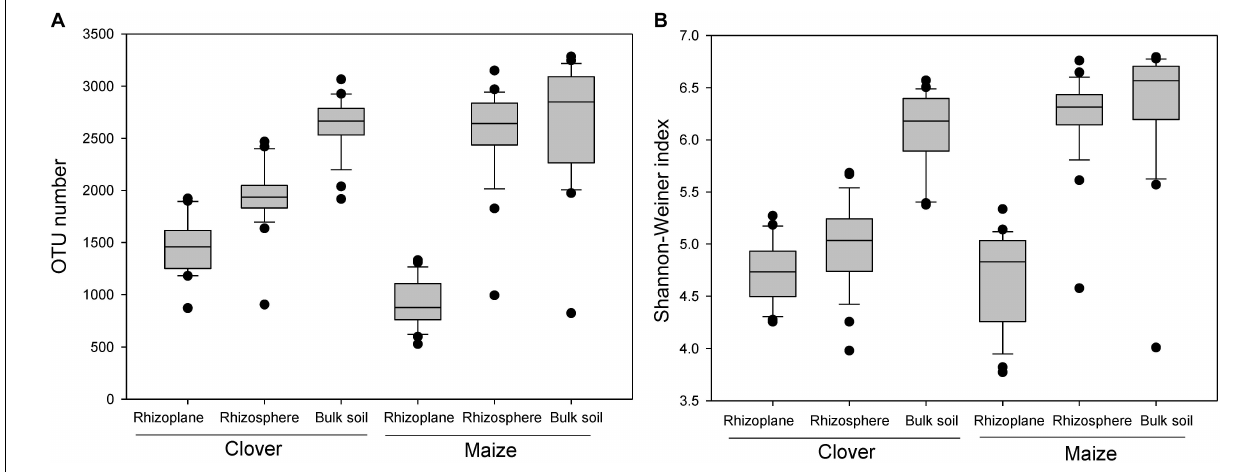
FIGURE 2 | Boxplot of alpha diversity of the bacterial community in different rhizocompartments (rhizoplane, rhizosphere, bulk soil) of maize and clover plants. (A) OTU number; (B) Shannon–Weiner index.